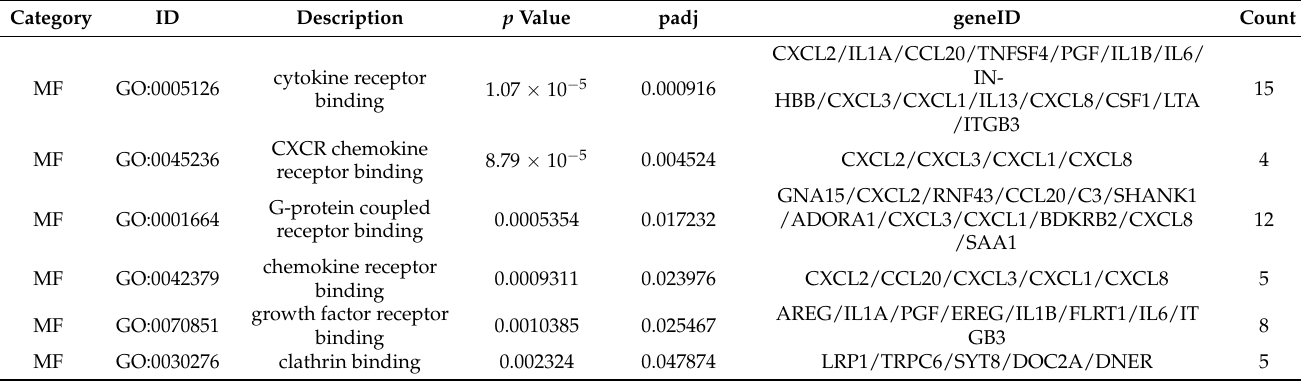
Table 2. The GO gene sets in molecular function involving receptors.